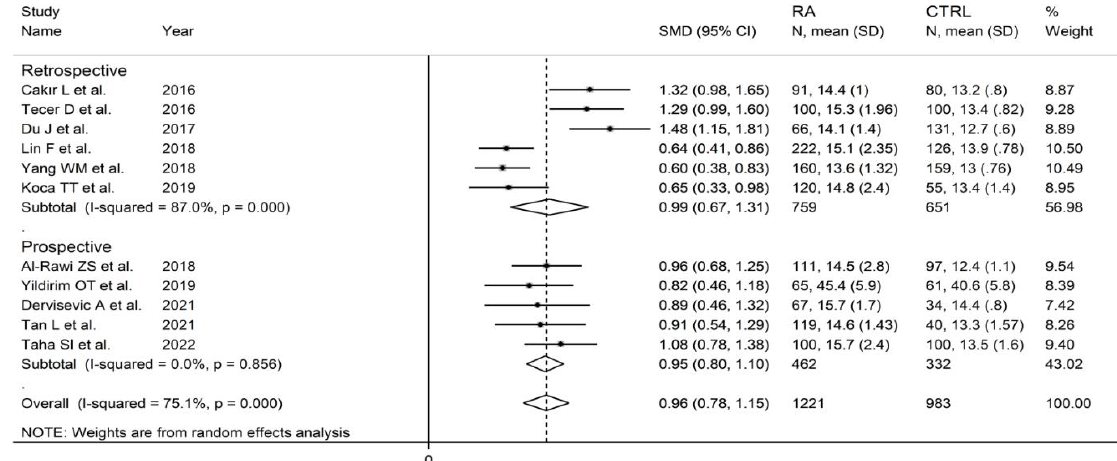
toid arthritis and healthy controls according to study design. arthritis and healthy controls according to study